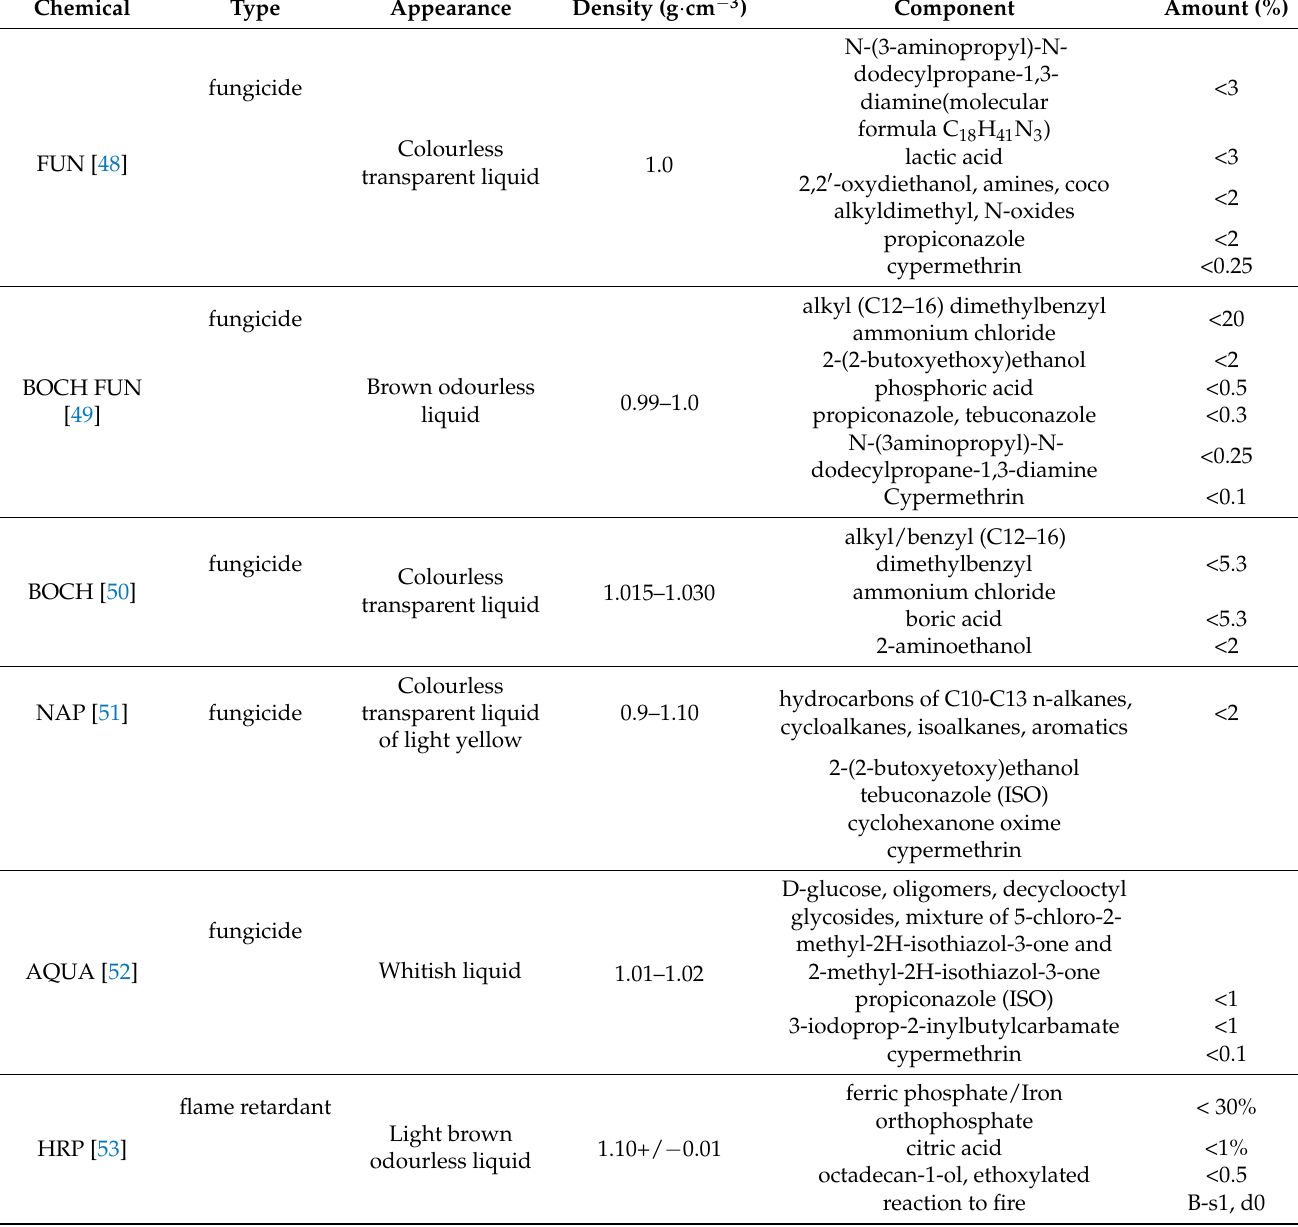
Table 2. Characteristics of fungicides and retardant